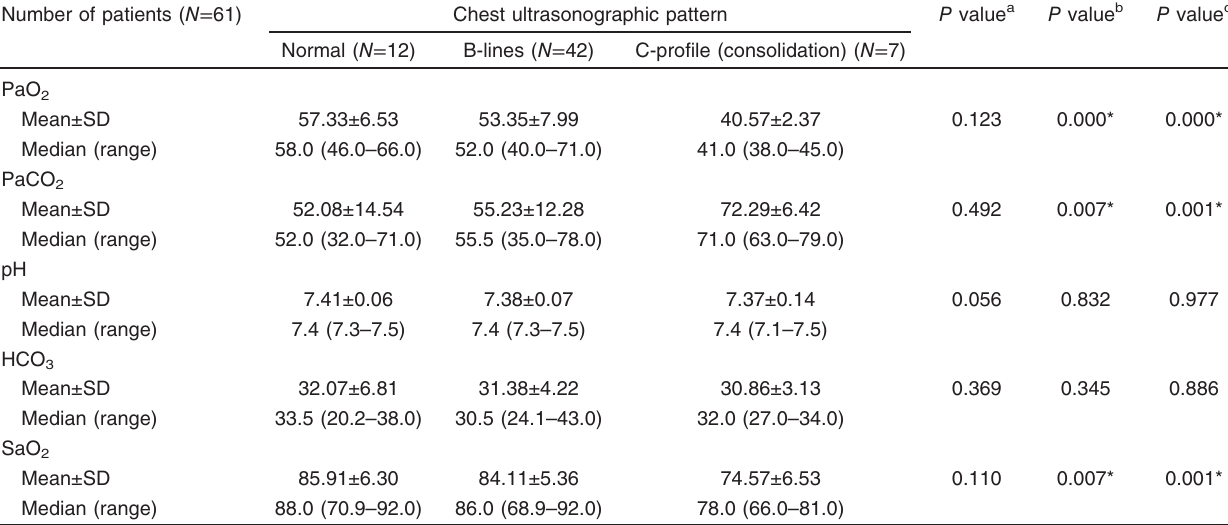
Table 3 Correlation between chest ultrasonographic pattern and blood gas parameters in all study population Number of patients ( N = 61)